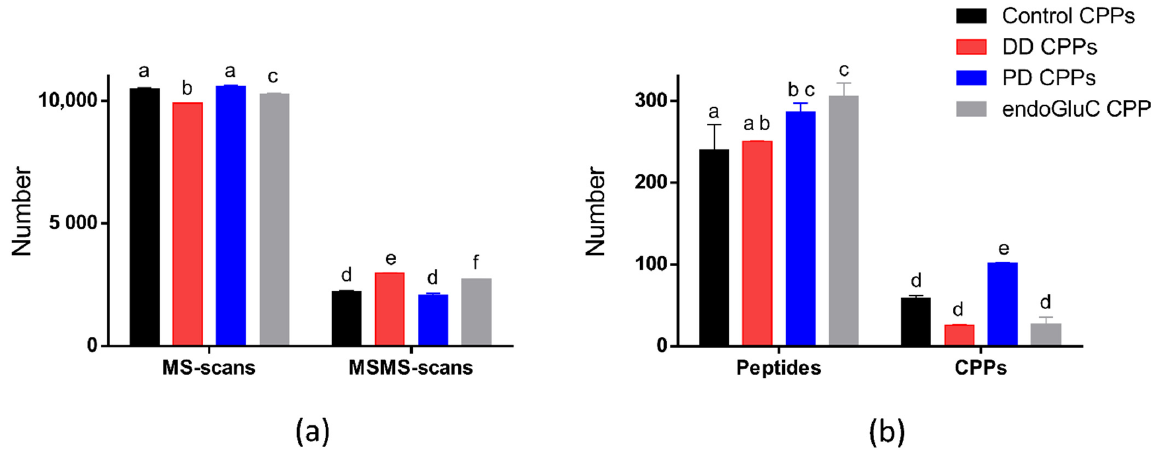
Figure 2. MS data, total identified peptides and identified casein phosphopeptides for the control- (in black), DD- (in red), PD- (in blue) and EndoGluC- (in gray) CPP hydrolysates. ( a ) Number of MS and MS/MSscans performed during the RP-HPLC-MS/MS runs; ( b ) number of identified peptides and identified CPPs with PEAKS Studio 8.5 software. All samples were analyzed in duplicate. The different lowercase letters report the statistically significant differences between data; an identical letter between two conditions indicates no statistically significant difference, whereas two different letters indicate a statistically significant difference ( p < 0.05, 2-way ANOVA multiple comparisons). Control—for no treatment; DD—for double-dephosphorylation; PD—for partial dephosphorylation; and endoGluC-CPPs—for endoGluC hydrolysis of CPP hydrolysates.